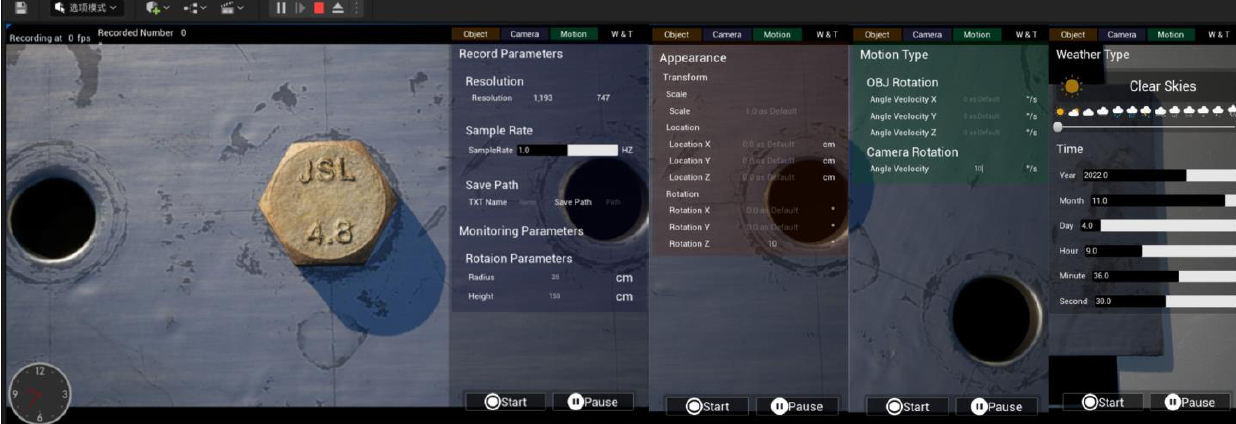
Figure 7. The UI of the virtual experiment platform in